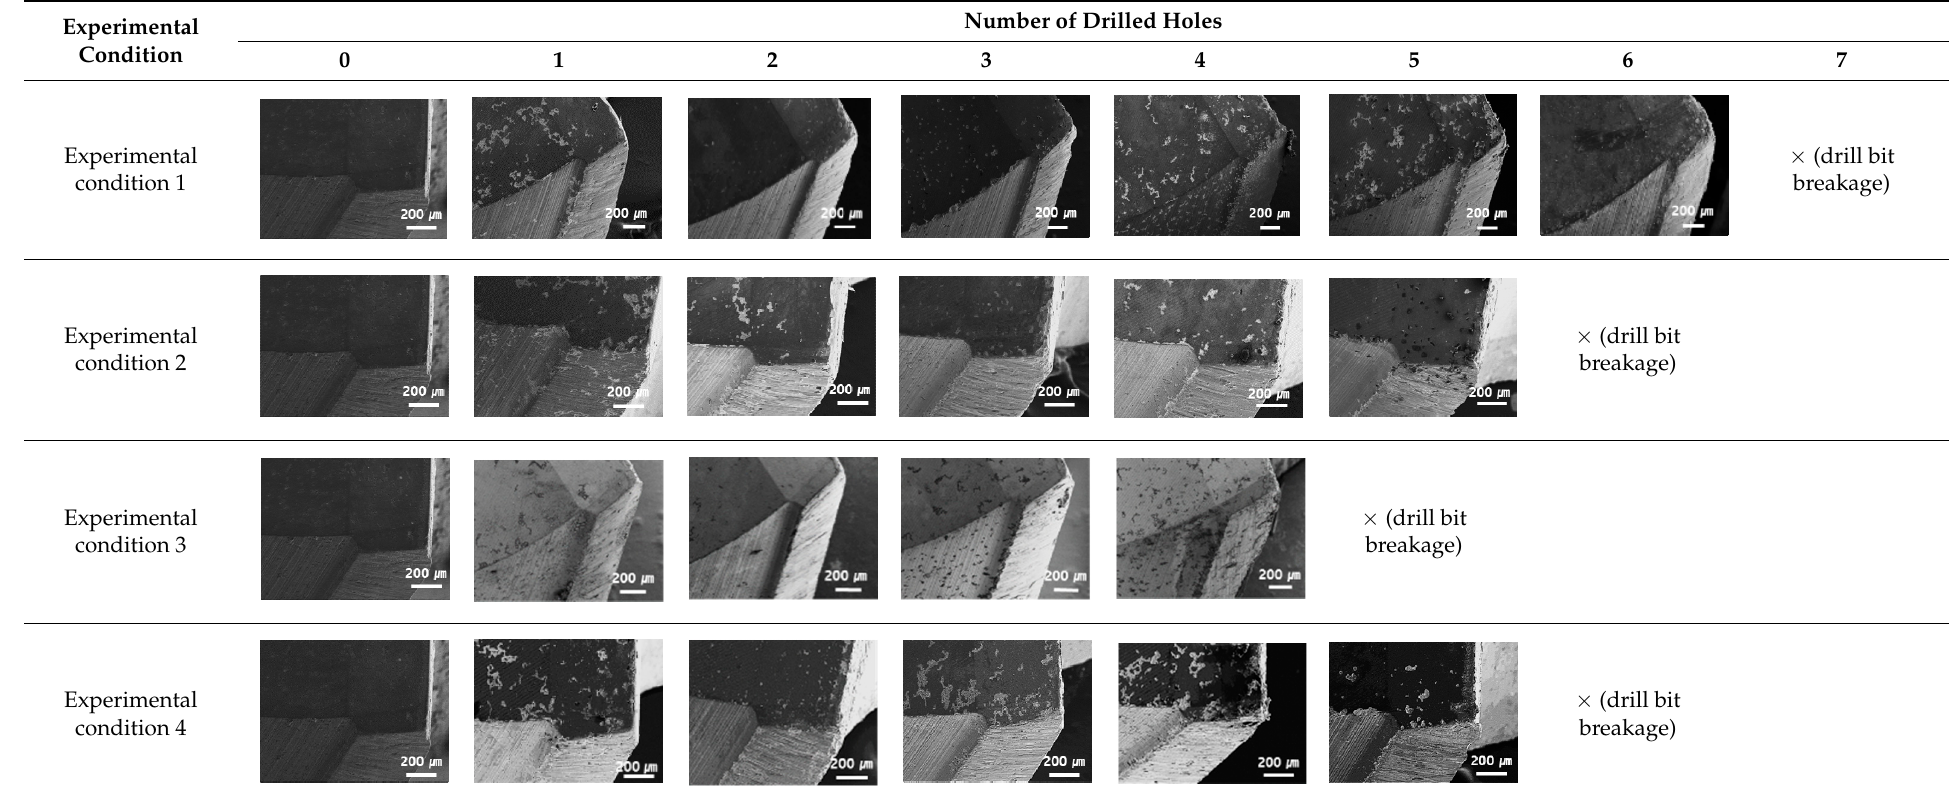
Table 5. Scanning electron micrographs of the outer corner of the drill bit for different numbers of drilled holes and experimental conditions.